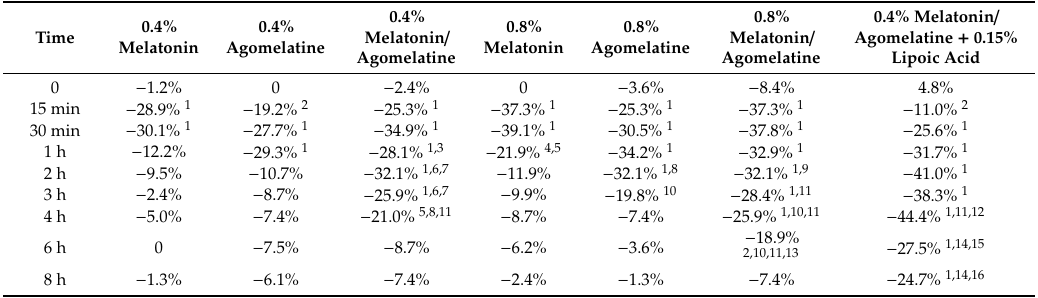
Table 2. Statistical analysis of data shown in Figure 3. Differences were calculated with respect to the intraocular pressure measured in rats instilled with saline.